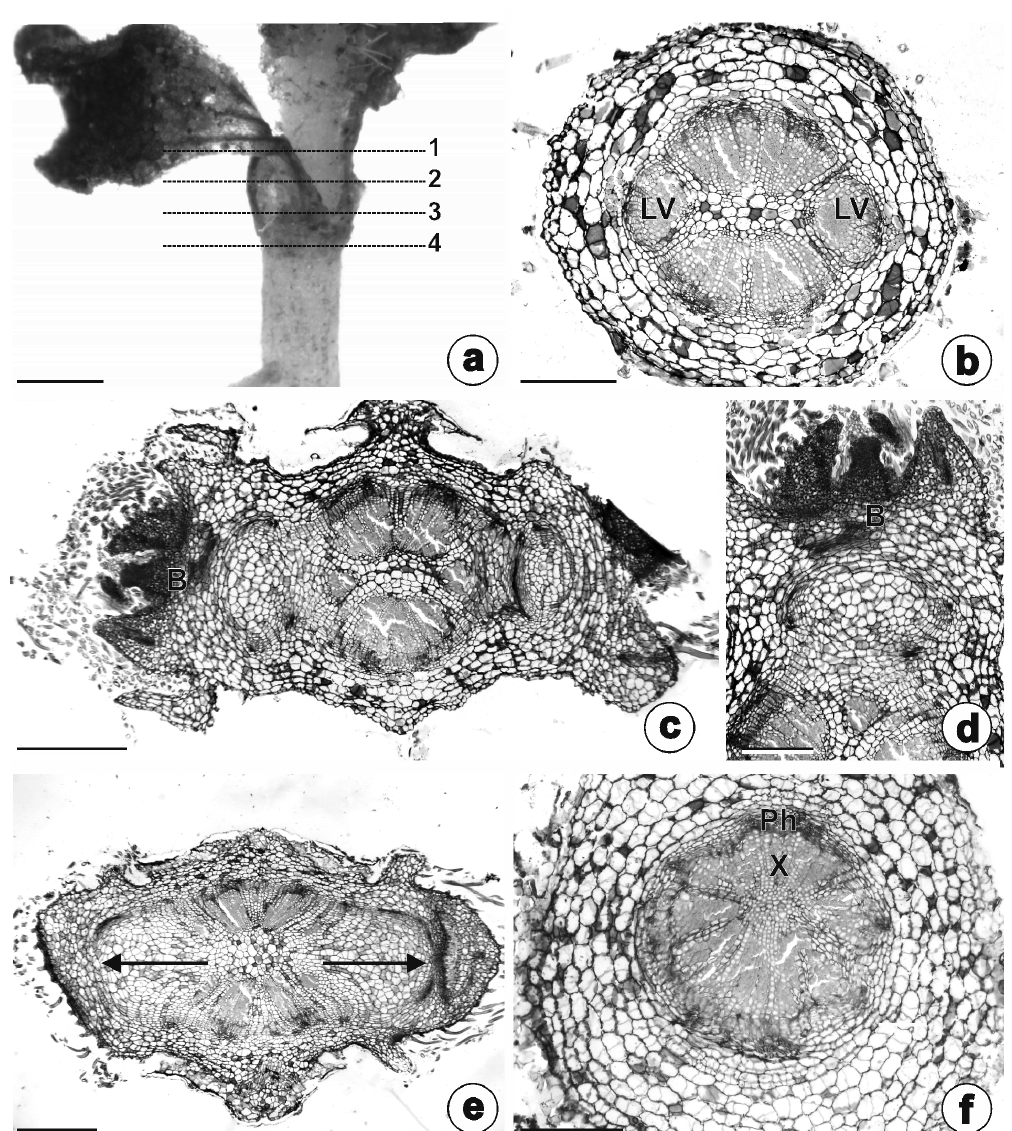
Figure 3 - Initial rhizophore development in a two-and-a-half-month-old Chrysolaena simplex . (a) Individual. (b-e) Cross-sections of the rhizophore. (b) Upper part with six collateral bundles. (c-d) Central part. (c) General view showing buds. (d) Detail of the bud. (e) Lower part showing lateral elongation (arrows). (f) Cross-sections of the hypocotyl. B: bud; LV: lateral vascular bundles; Ph: primary phloem; X: primary xylem. Section planes analysed: 1: upper part of the rhizophore; 2: central part; 3: lower part; 4: hypocotyl. Scale bars, 2 mm (a) ; 500 μ m (b, d, f) ; 1000 μ m (c, e) . See the colors in the online